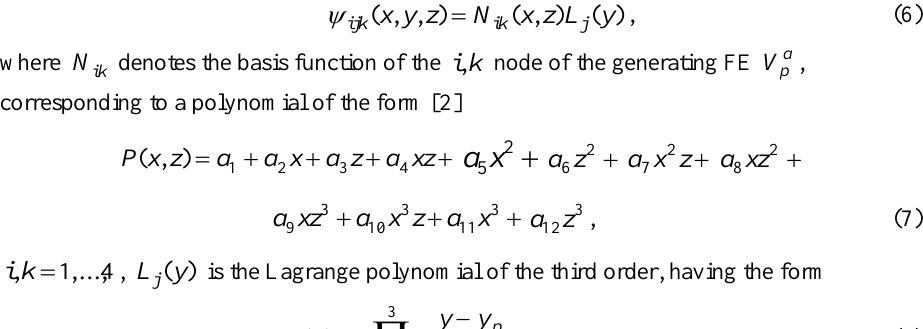
V . Fig. 4. Generating 1gFE ap V Fig. 3. Beam 2gFE p